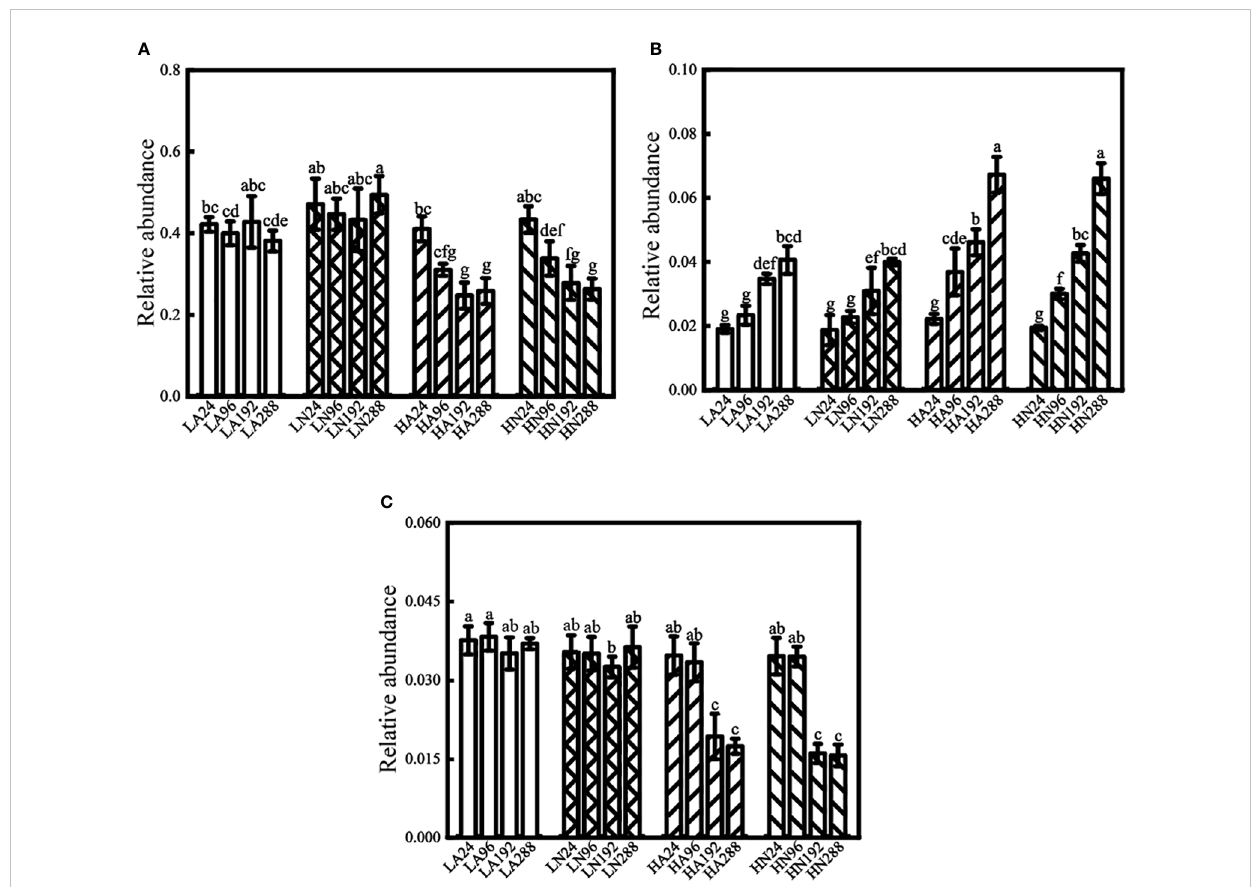
FIGURE 5 Relative abundance of Marivita (A) , Oceanicaulis (B) , and Marinobacter (C) under different conditions in the algal-bacteria co-culture system. Error bars represent the standard error of the mean of three independent experiments. Different lowercase letters indicate statistically signi fi cant differences.